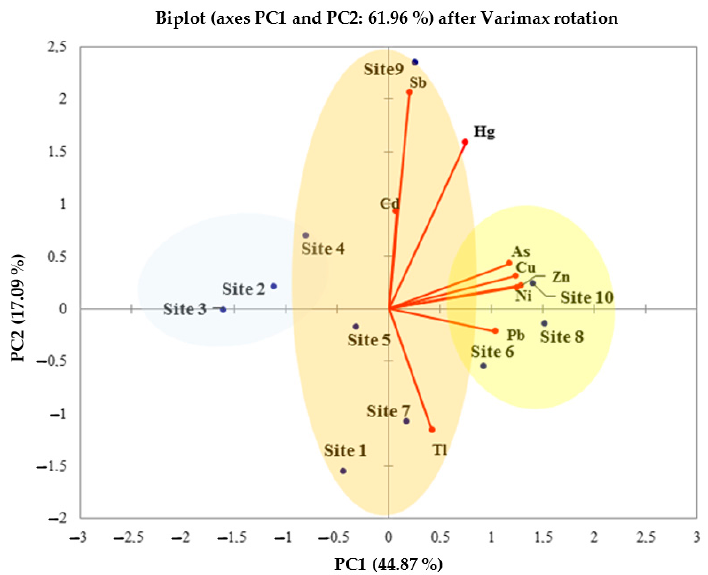
Figure 2. 2D plots of the first two PCs obtained through PCA elaboration after the Varimax rotation.